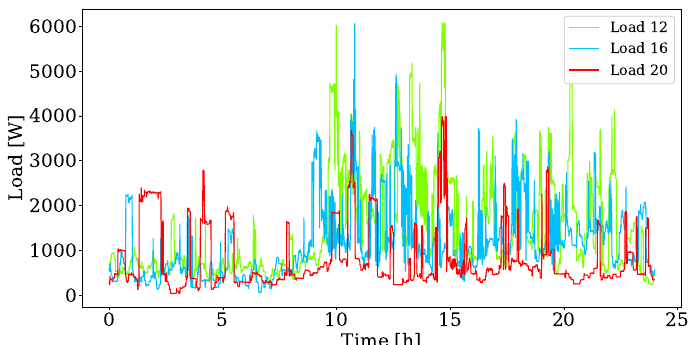
Figure 5. Example of load profiles for some of the nodes of the grid.